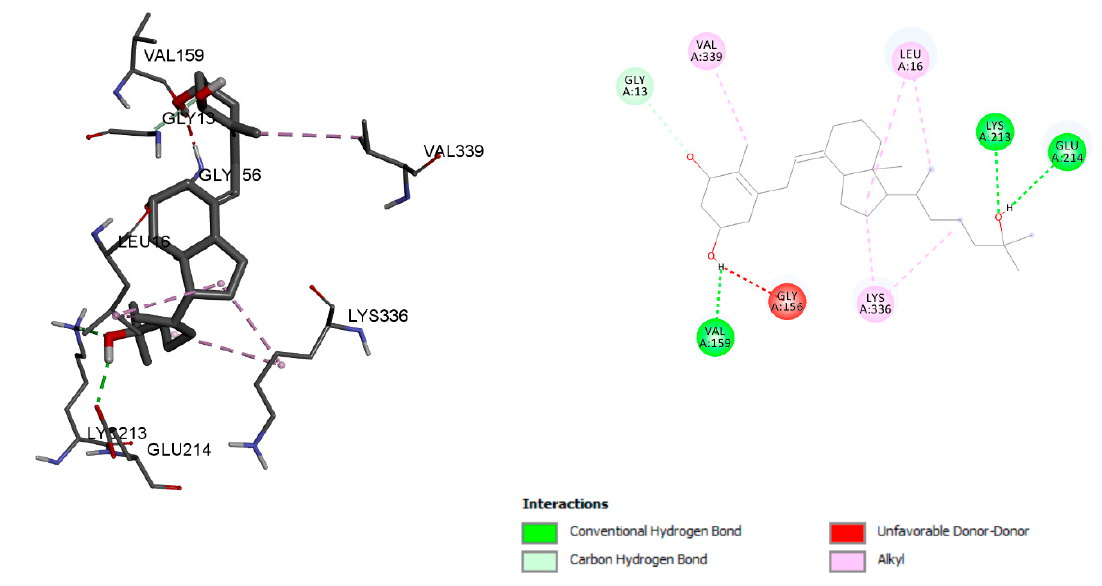
Figure 3. Calcitriol molecular interaction with the vitamin D binding protein.